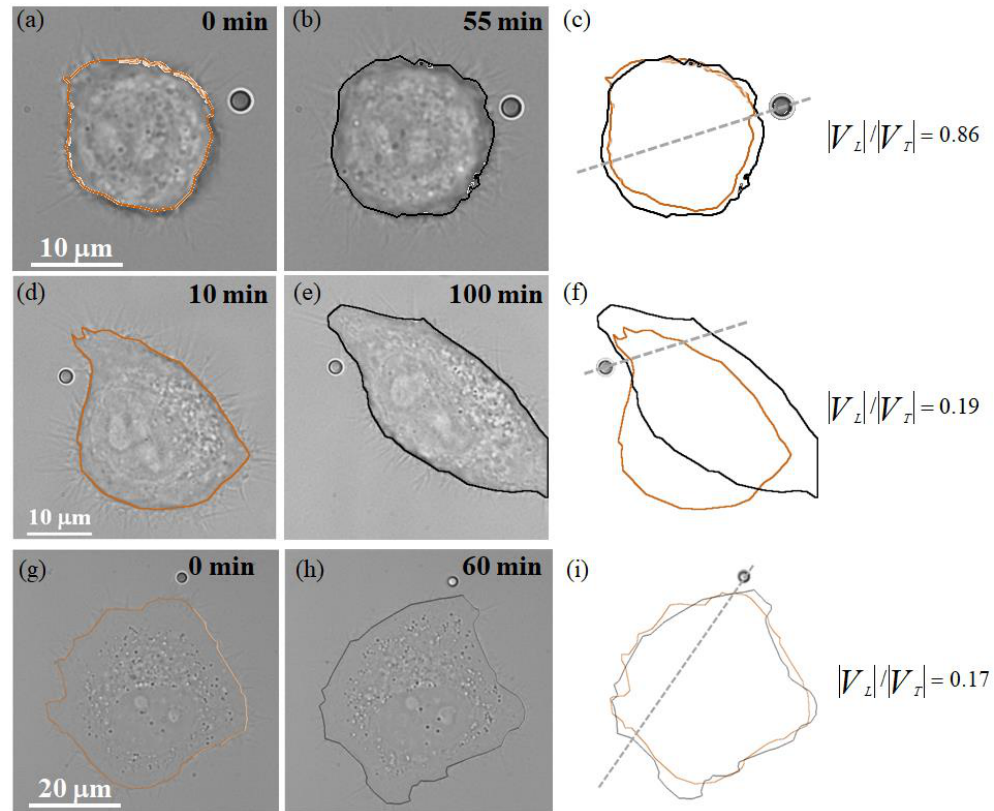
Figure 5. Consecutive bright-field images of individual cellular responses during stuck streptavidin-coated-bead stimulation, where the stuck bead was intended to contact the filopodial actin filament of the HT29 cell. ( a , b , d , e , g , h ) The HT29 cells at the t 0 and t 1 time points, respectively. ( c , f , i ) The corresponding 2D cell body contours and the value of |𝑉 𝐿 ⃑⃑⃑ |/|𝑉 𝑇 ⃑⃑⃑⃑ | during the stuck streptavidin-coated-bead stimulation.